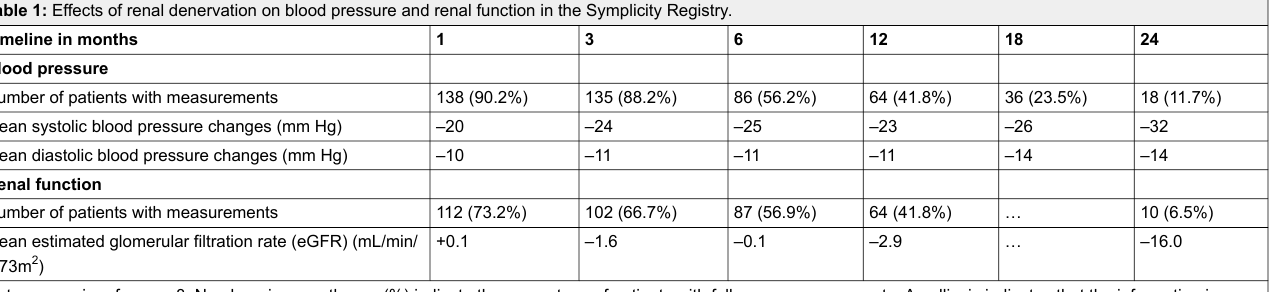
Effect of sympathetic afferent and efferent nerves. Solid and dashed lines represent afferent and efferent nerve traffic, respectively. Abbreviations: LV, left ventricular; GFR, glomerular filtration rate.